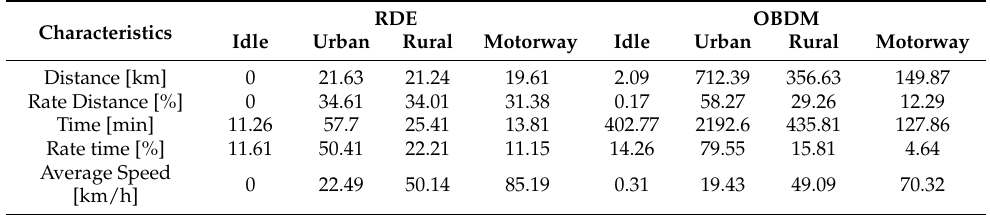
Table 6. RDE-OBDM